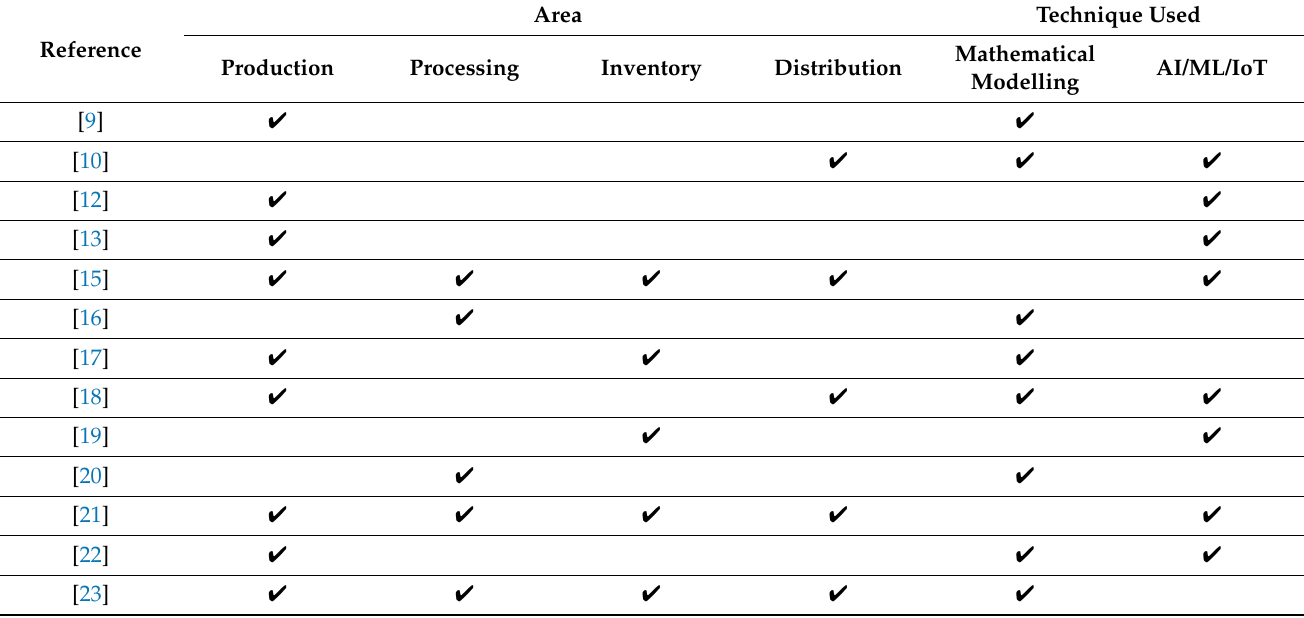
Table 2. Optimization techniques applied in